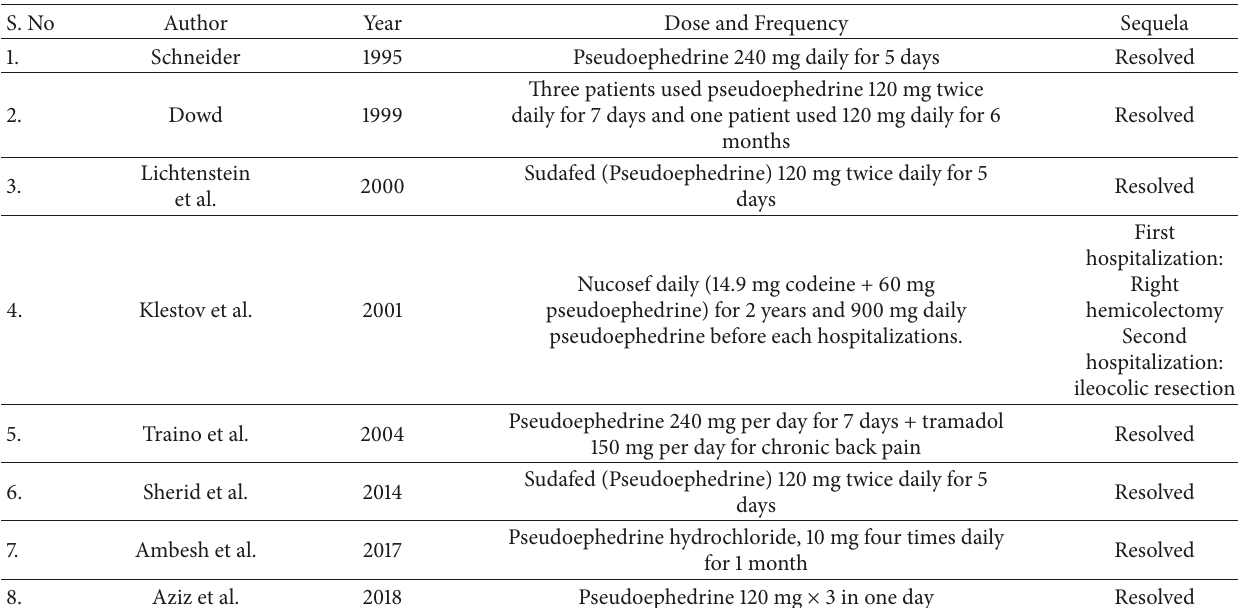
Table 2: Previously reported dosing for pseudoephedrine in patients presenting with ischemic